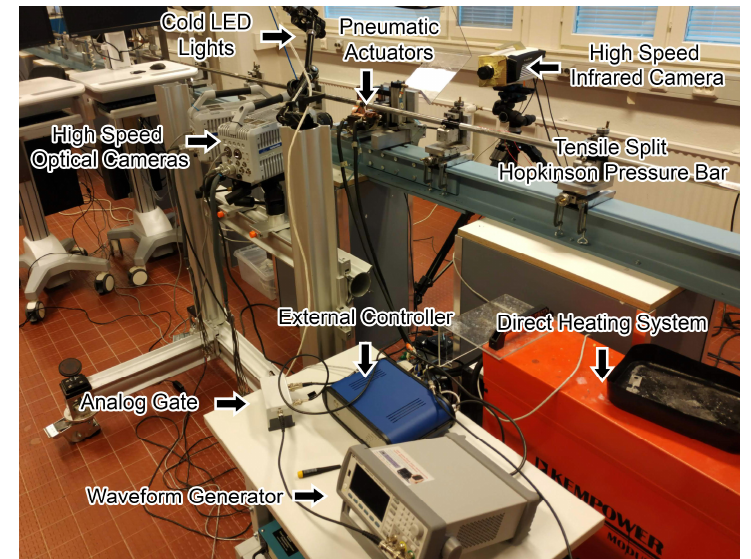
Fig. 1. Experimental setup used for the high temperature tests comprising the direct electric heating system, the high-speed infrared, and optical cameras, and the tensile